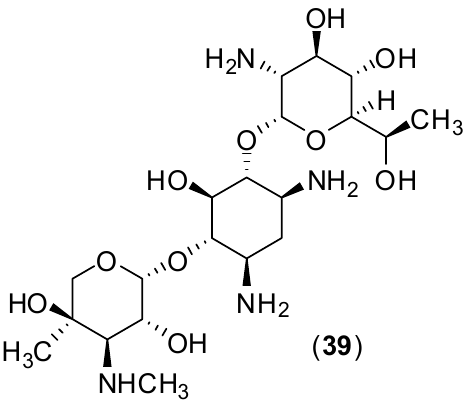
Figure 16. Structure of the aminoglycoside geneticin ( 39